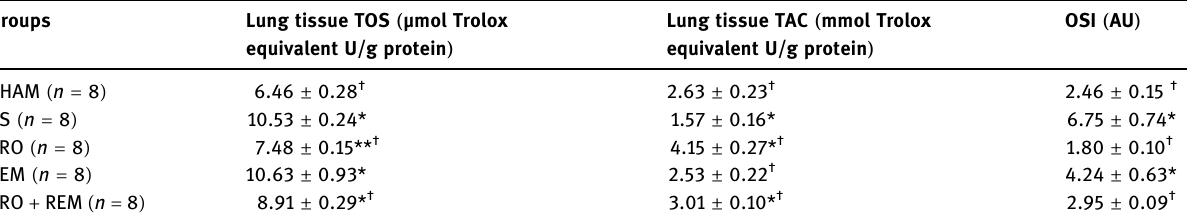
Table 2: Total oxidative stress ( TOS ) and total antioxidant capacity ( TAC ) of lung tissues Groups